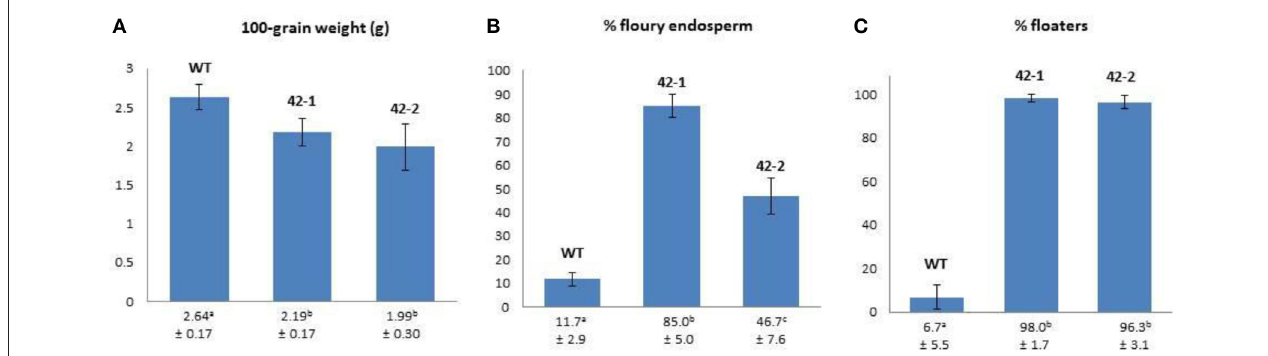
FIGURE 1 | A comparison of 100-grain weight (A) , % floury endosperm (B) , and % floaters (C) between wild-type (WT) and transgenic sorghum genotypes 42-1 and 42-2. Values below the bars on the charts correspond to the mean ± SD. Means sharing the same superscript are not significantly different at p < 0.05.